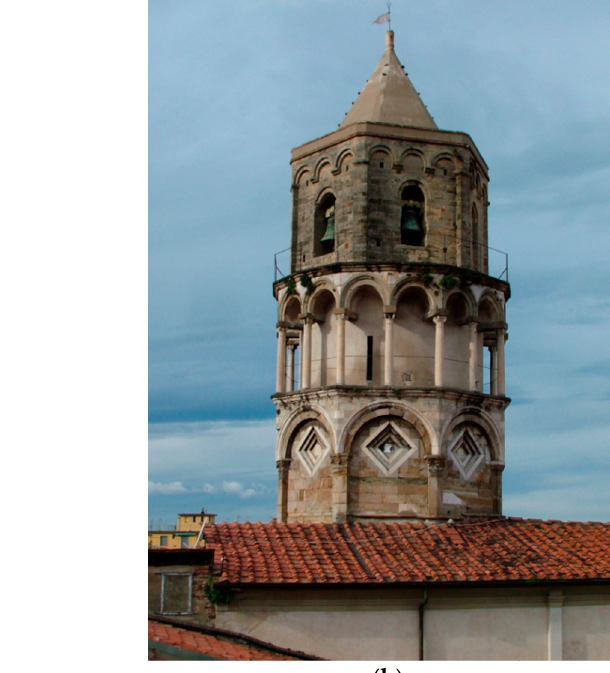
Figure 13. The south wall of St. Nicola Church.